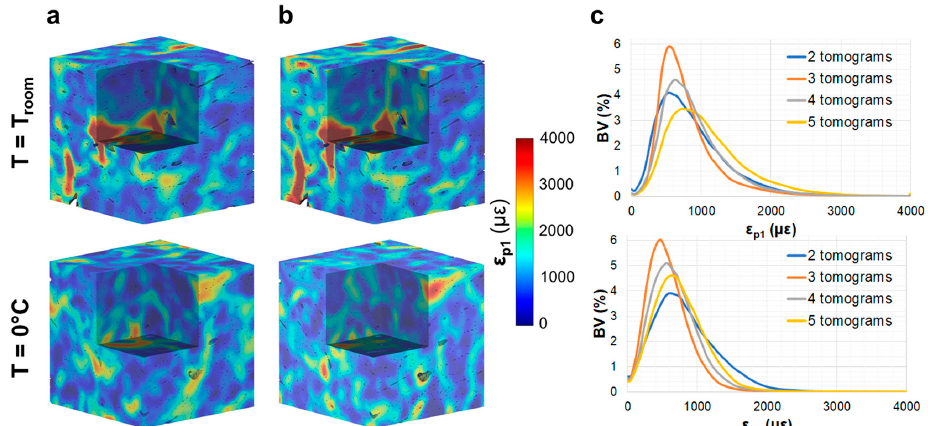
Figure 3. Three-dimensional first principal strain ( ε p1 ) distribution in compact bone tissue imaged at room temperature (top) and 0 °C (bottom) after two ( a ) and five ( b ) acquired tomograms. A representative cube (~1 mm 3 ) in the centre of the analysed VOI is represented. Histograms of the residual strain distribution ( c ) in the tissue are shown for all the acquired tomograms.